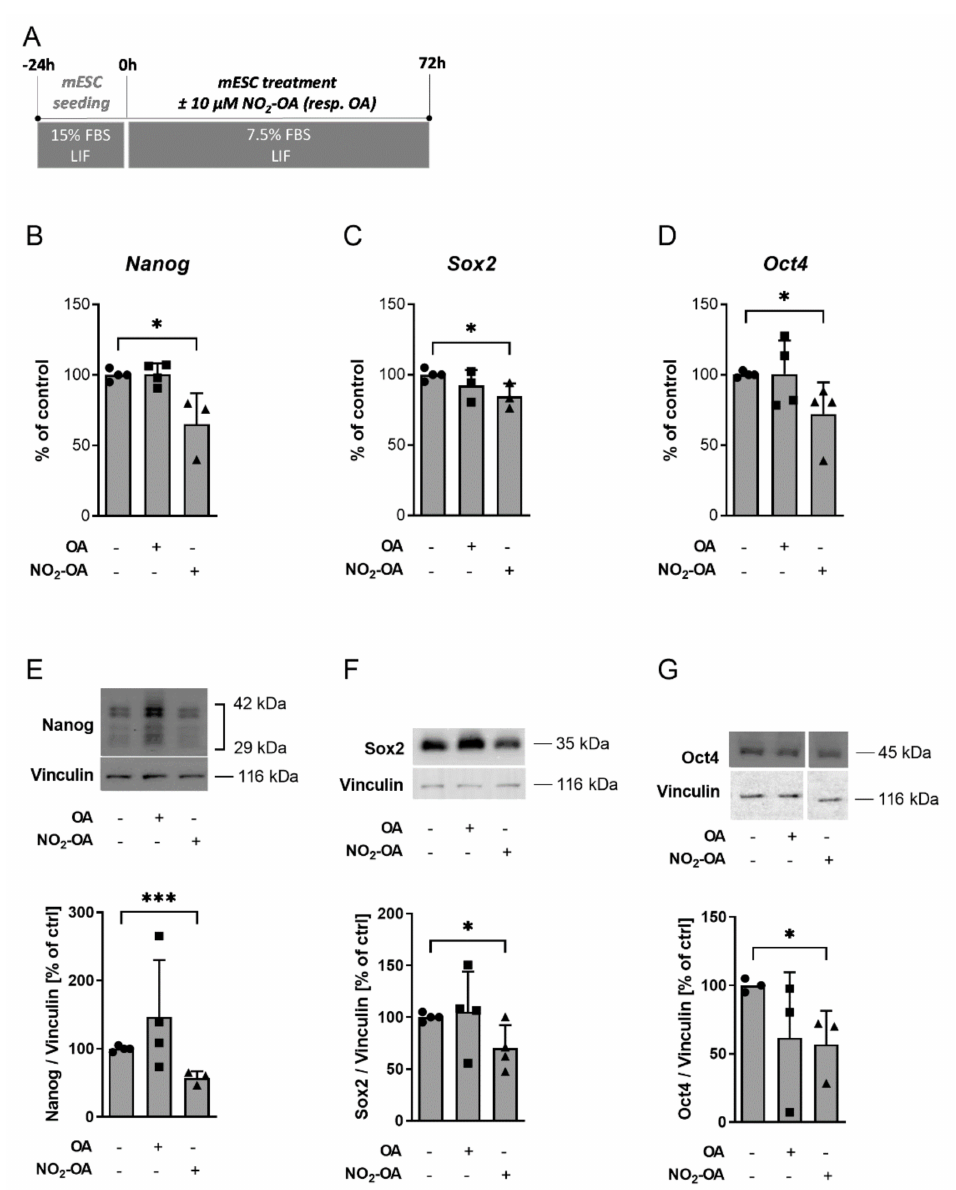
Figure 1. NO 2 -OA significantly inhibits the expression of pluripotency markers in mESC. ( A ) Time-scheme of the mESC treatment used in this experiment. ( B – G ) The levels of selected markers of pluripotency; ( B ) Nanog , ( C ) sex-determining region Y-box 1 transcription factor ( Sox2 ), and ( D ) octamer-binding transcription factor 4 ( Oct4 ) were evaluated by real-time quantitative PCR ( B – D ) and Western blot ( E – G ) in mESC incubated for 72 h in experimental medium plus leukemia inhibitory factor + 7.5% FBS and treated by NO 2 -OA or OA (10 µ M). Data are expressed as means and standard deviation from at least three independent experiments. Statistical significance was determined by unpaired student’s t -test; statistical differences compared to non-treated control were analyzed, * p < 0.05, *** p <